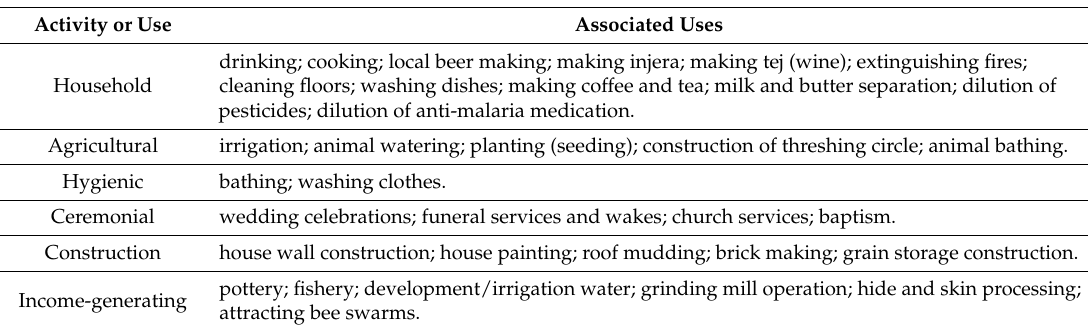
Table 3. Water Uses Identified During the Workshop.